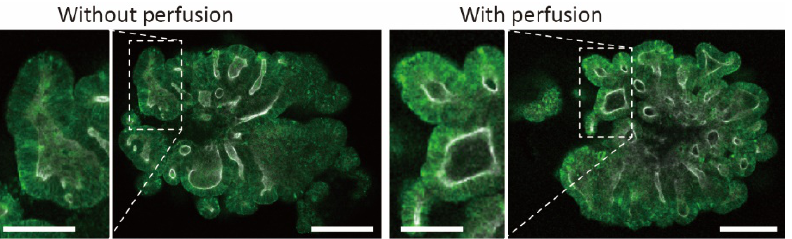
Figure 8. Budding formation of perfused organoids, showing localization of lysozyme (paneth cell marker) in the intestinal organoid with and without perfusion culture. Green shows lysozyme and white shows actin. Scale bars are 200 µm (overall image) and 100 µm (magnified image).